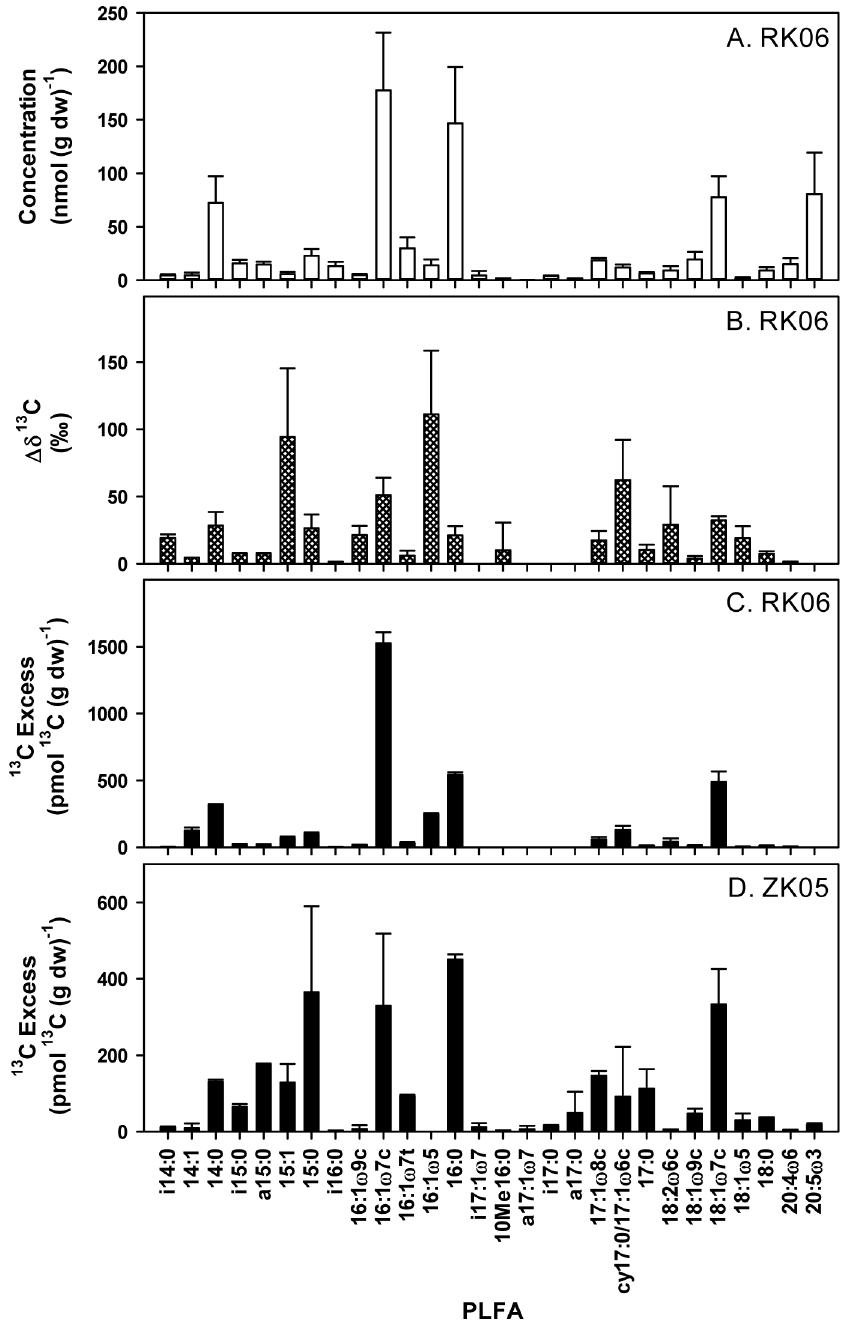
Figure 3. PLFA concentrations (A), Dd 13 C ratios (B) and excess- 13 C (C) for RK06 (0 – 0.5 cm horizon) after 1 day of incubation with 13 C-DIC. The excess- 13 C PLFA data for ZK05 (0-0.5 sediment horizon) after 2 day of incubation are also shown for comparison